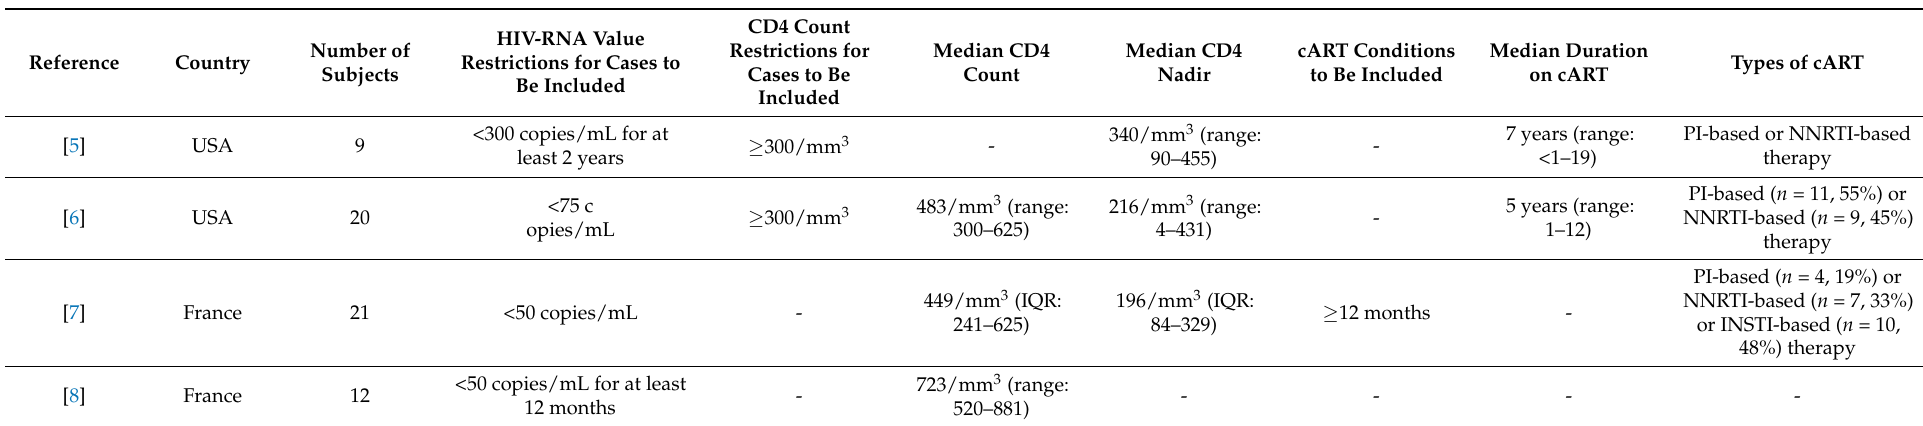
Table 1. Main published series including Kaposi’s sarcoma in HIV-patients with suppressed